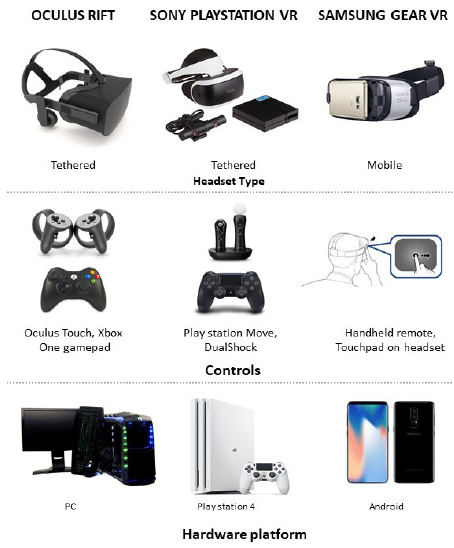
Figure 10. The most commonly used VR devices and software for the development of immersive VR projects.